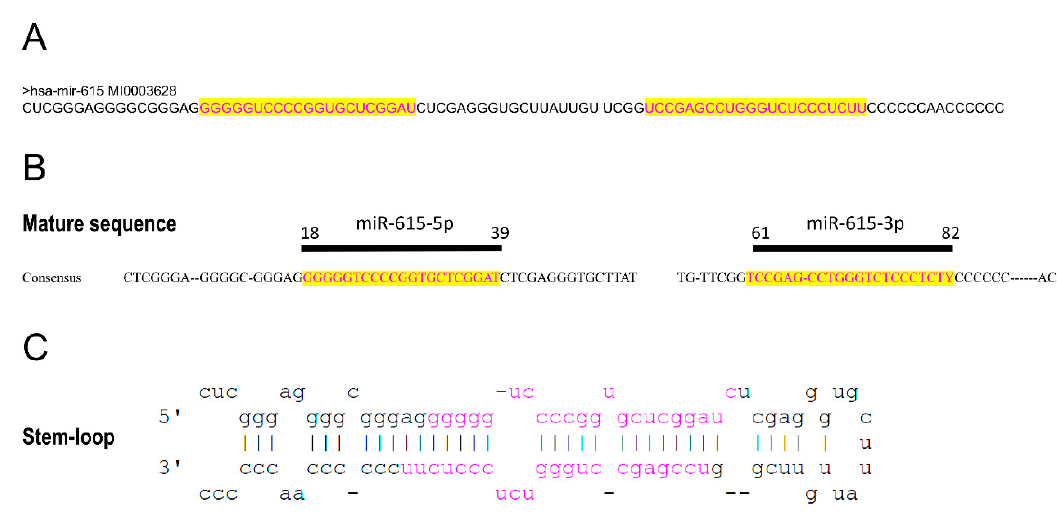
Figure 1. ( A ) Human miR-615 sequence obtained from miRbase. ( B ) Consensus sequence of miR-615 obtained from several vertebrates [6], including sequences of miR-615-3p and 5p. ( C ) Stem-loop of miR-615 [7] .